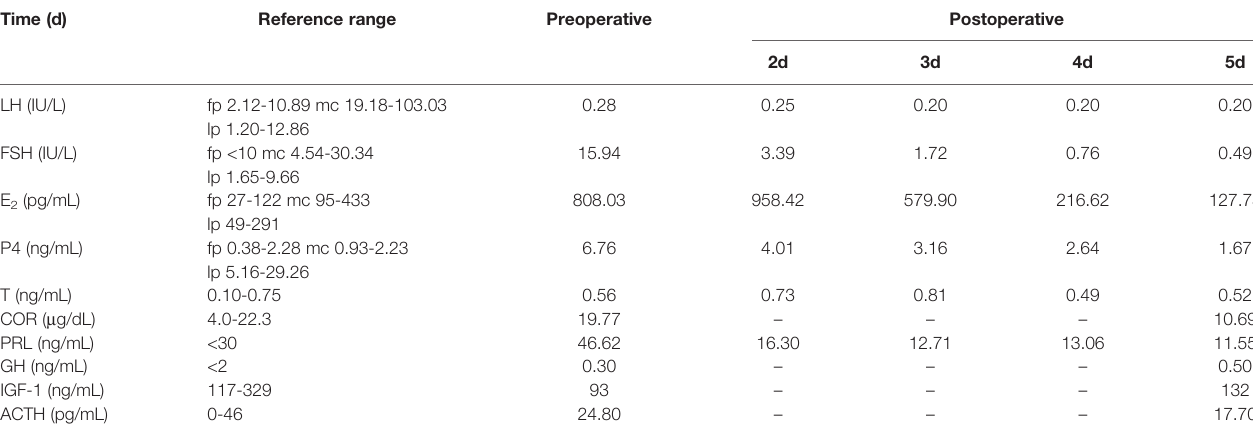
TABLE 4 | Serum hormone levels before and after pituitary transsphenoidal surgery to remove FSH-secreting adenoma. Time (d) Reference